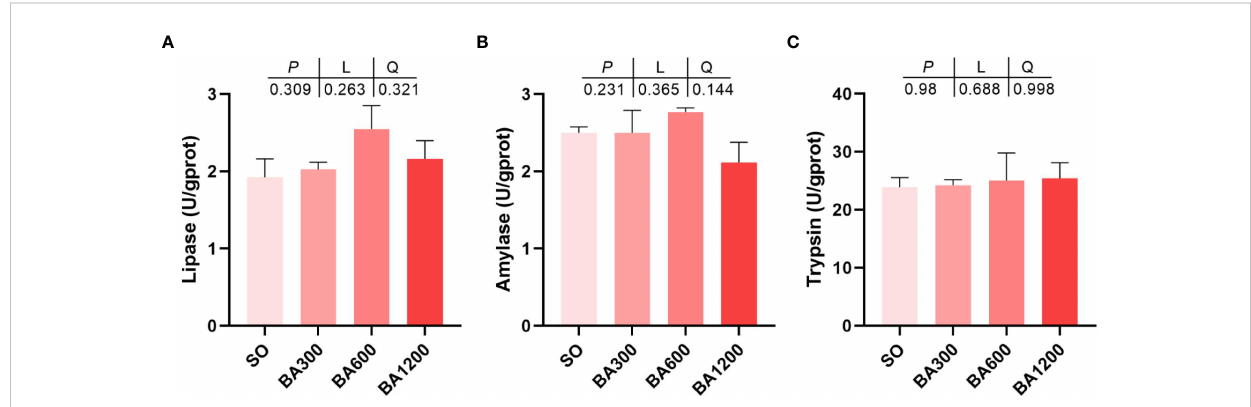
FIGURE 2 Activities of main digestive enzymes in the intestine of juvenile large yellow croaker in different treatments. (A) , Lipase; (B) , Amylase; (C) , Trypsin. Values are represented as mean ± SEM (n =